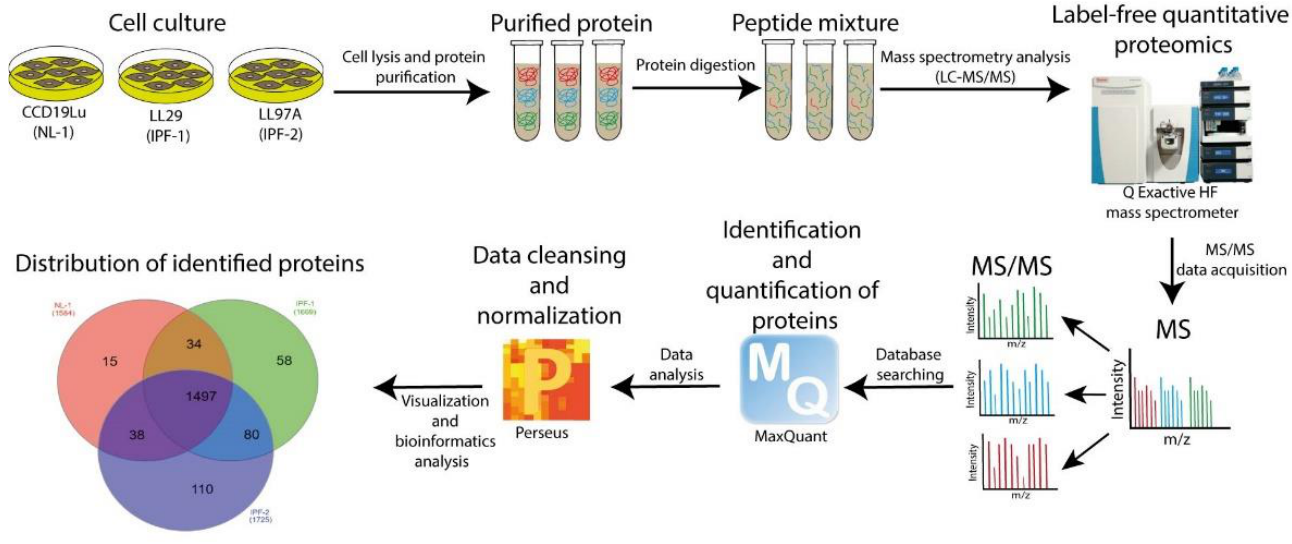
Figure 1. Schematic representation of the experimental design and workflow of label-free proteomic analysis. Cell lines are subjected to cell lysis and processed to extract proteins. These are digested and analyzed by LC-MS/MS. Peptides are identified and quantified by label-free methods.